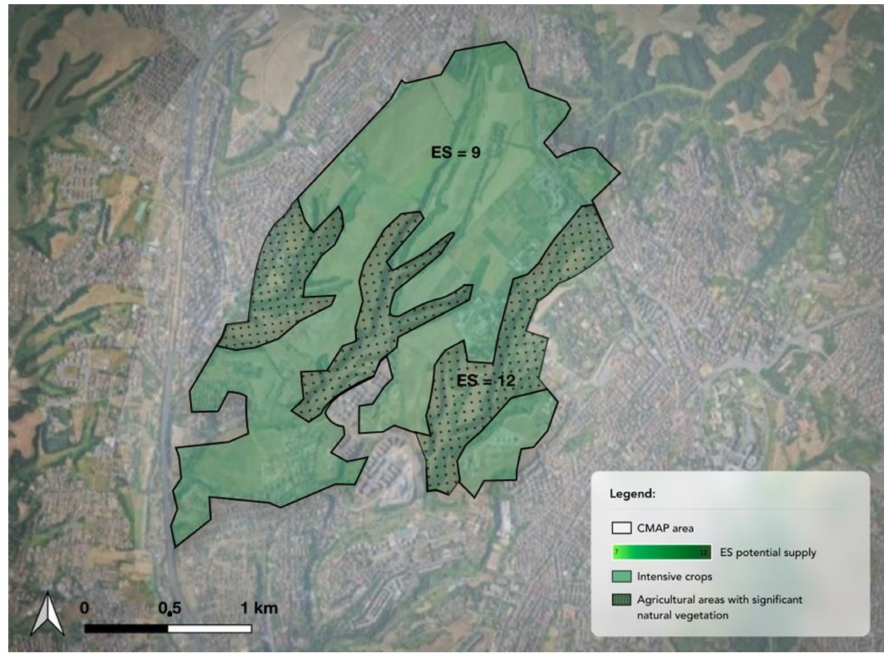
Figure 4. CMAP area: ES mapping and assessment.